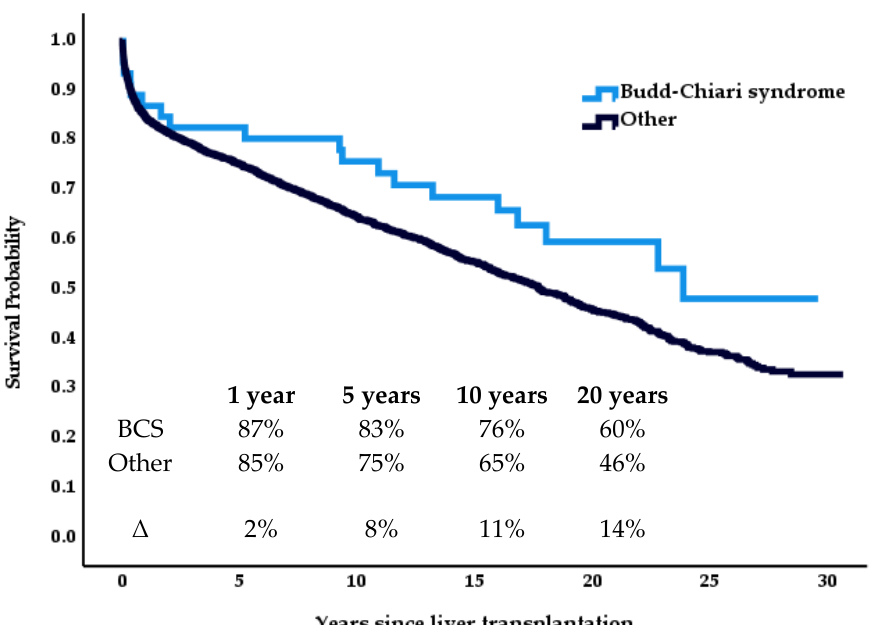
Figure 3. Cumulative survival—Budd-Chiari syndrome ( n = 46) vs. other indications ( n = 2677).